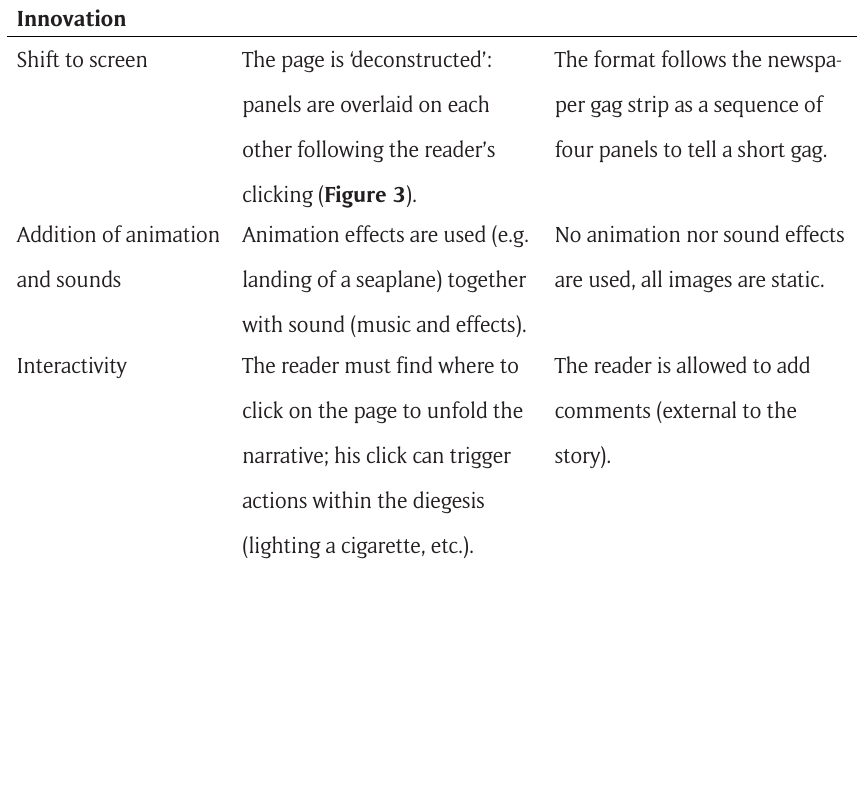
Table 1: Comparing John Lecrocheur and Sans emploi : what formal innovations? Table by Julien Baudry,